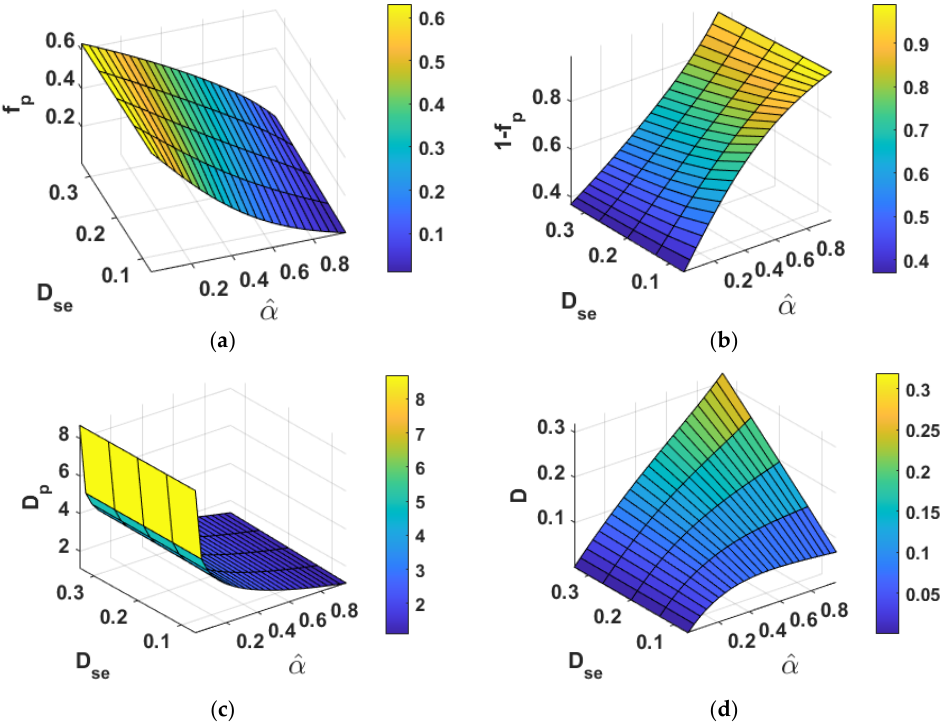
Figure 3. Analytical results from Equation (22) are shown for biexponential model parameters ( a ) f p , ( b ) 1 − f p , ( c ) D 0 , and ( d ) D, as functions of stretched exponential parameters D se and ˆ α , when b = 0, 1, 2, 3 and D se · b max ≤ 1.